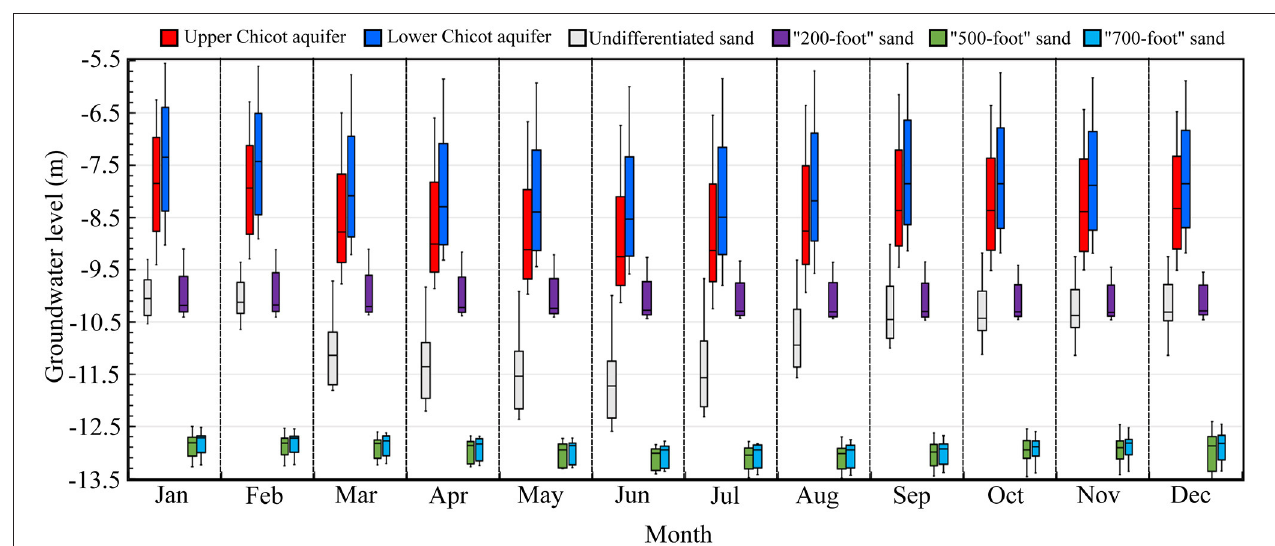
Frontiers in Water |